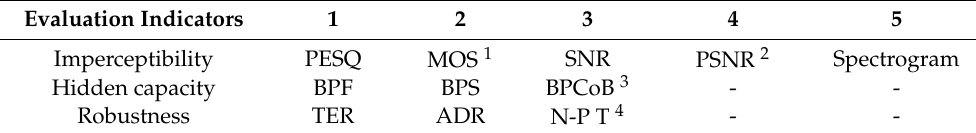
Table 3. Evaluation coefficients in steganography.